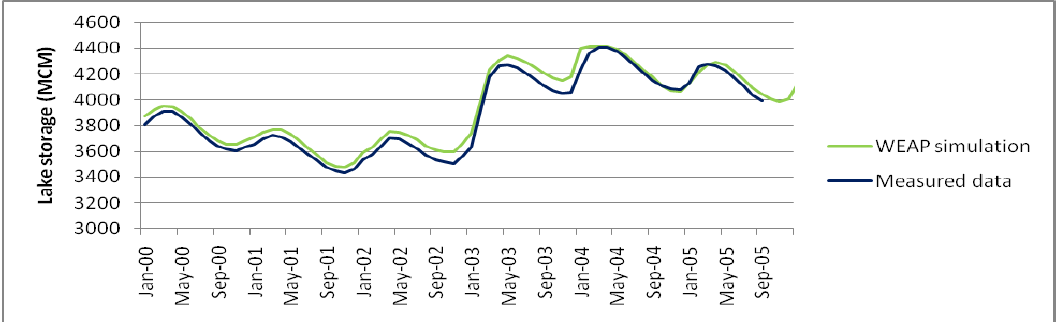
Figure 4. Comparison of WEAP simulated vs. measured lake volume in million cubic meters (MCM).